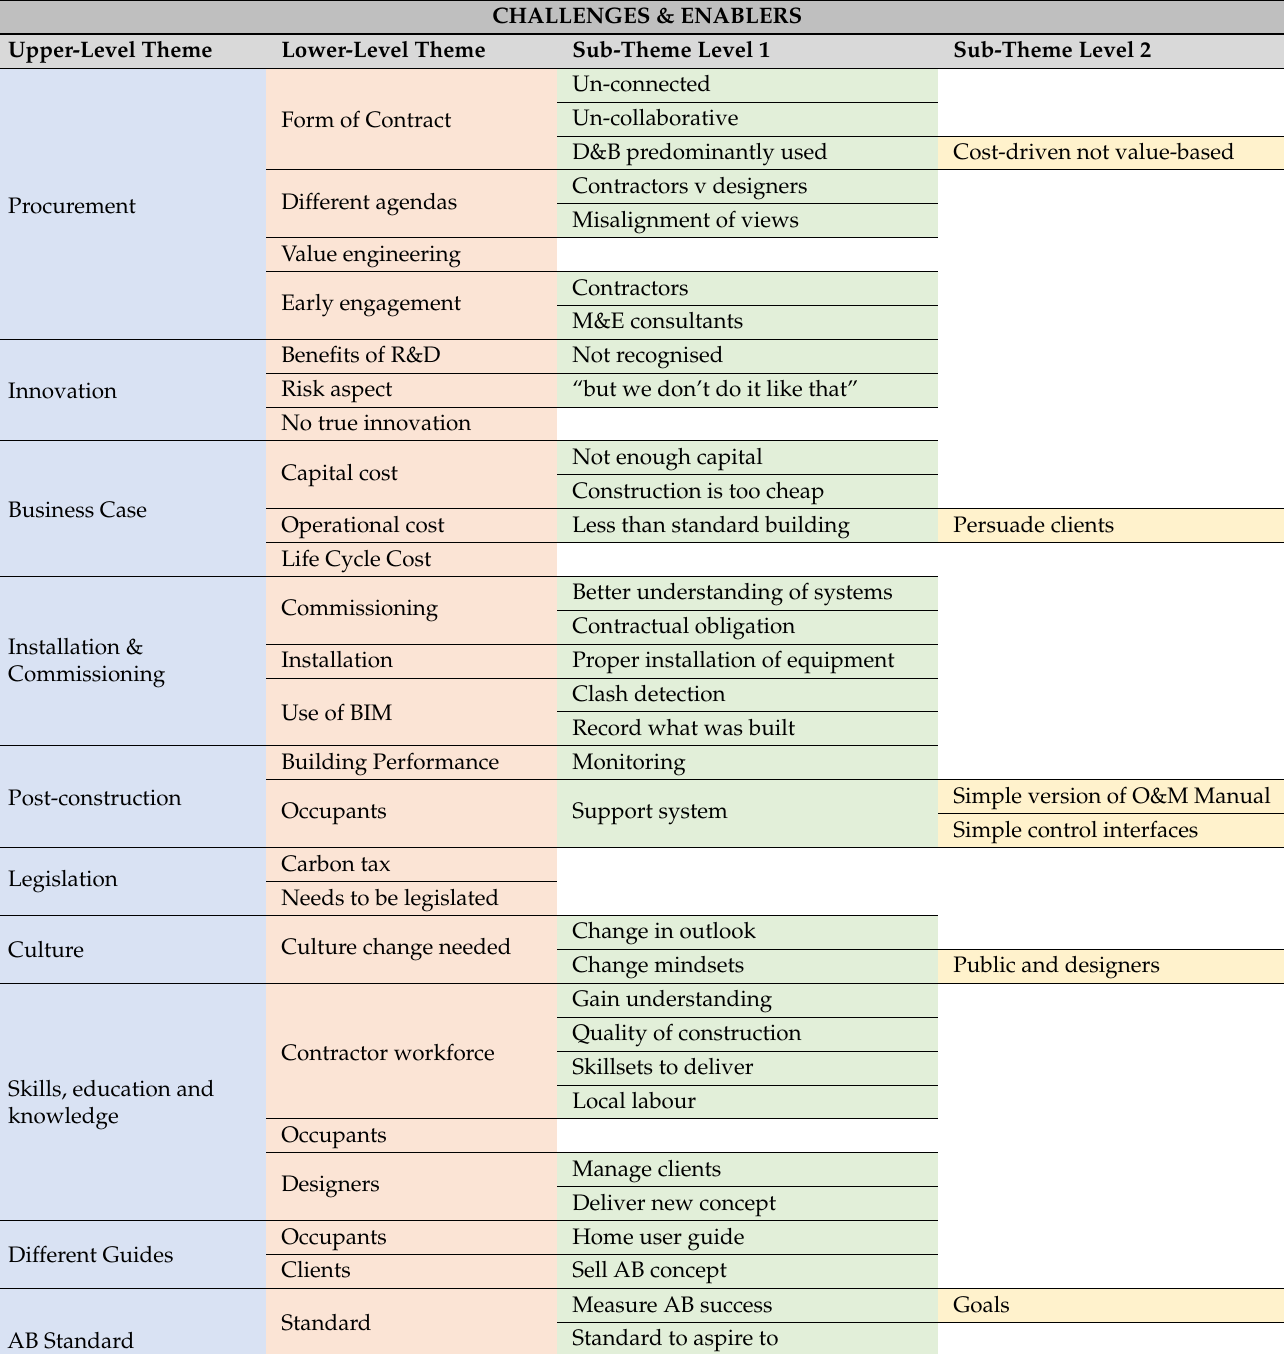
Table 5. Summary of themes developed from all FGs, in addition to data collected on ABDG